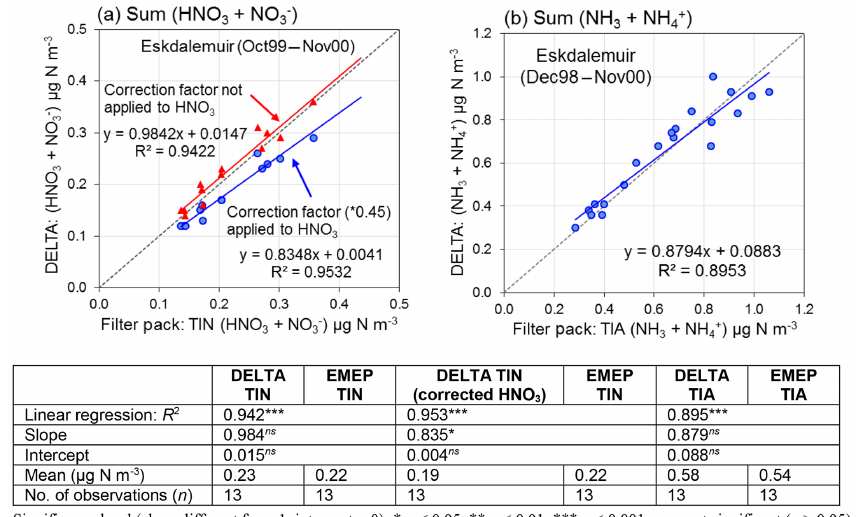
Figure 4. Comparison of (a) total inorganic nitrate, TIN (sum of HNO 3 + NO − concentrations at the Eskdalemuir monitoring station (EMEP station code = GB0002R; UK-AIR ID = UKA00130) measured under the EMEP program with concentrations of the corresponding gas and aerosol from the UK Acid Gases and Aerosol (AGANet, HNO 3 and NO − and UK National Ammonia Monitoring Network (NAMN, NH 3 and NH + for TIN and TIA by the EMEP filter pack method, matched to the AGANet and NAMN sampling periods (monthly). Filter pack measurements at Eskdalemuir terminated in December 2000. A summary of the regression analyses is provided in the table below the